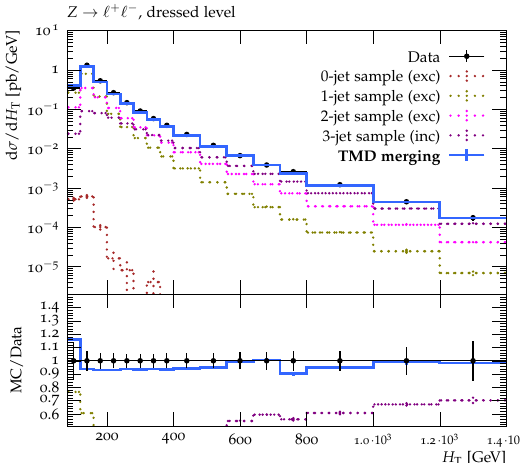
Figure 18 . Scalar sum H T of the transverse momenta of leptons and jets for Z + jets events. √ Experimental measurements by ATLAS [91] at s = 13 TeV are compared to predictions using the TMD merging calculation. Separate contributions from the different jet samples are shown. All the jet multiplicities are obtained in exclusive (exc) mode except for the highest multiplicity which is calculated in inclusive (inc) mode.